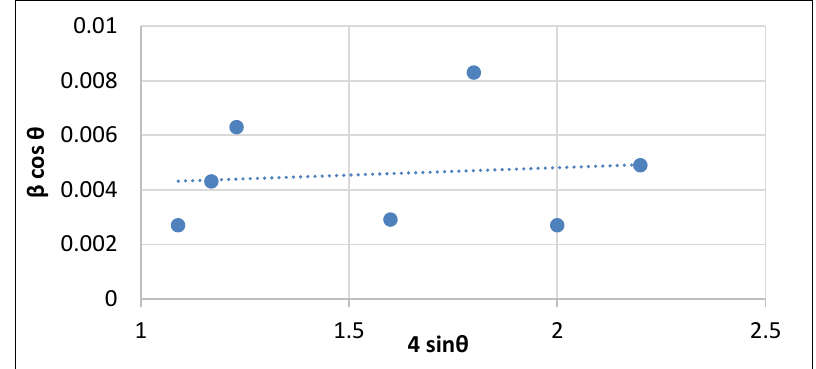
Fig. 3: The strain of nanostructured ZnO.